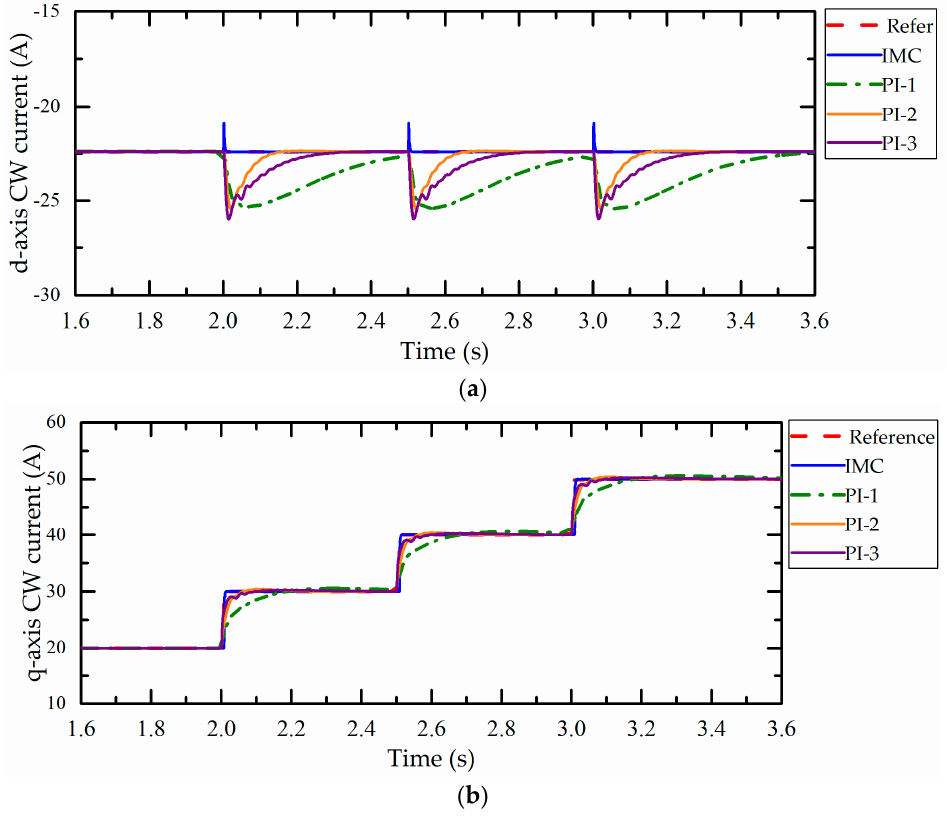
Figure 12. Dynamic responses of the CW current with different control methods. ( a ) i cd ; ( b ) i cq .